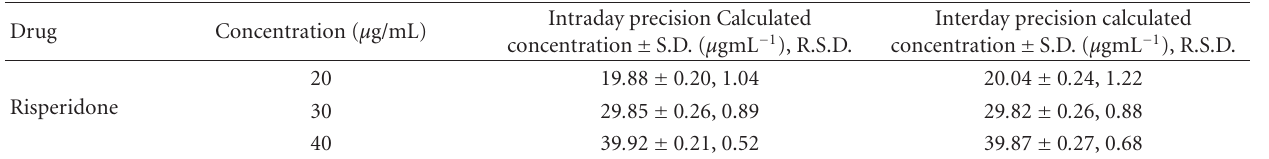
Table 1: Precision study.